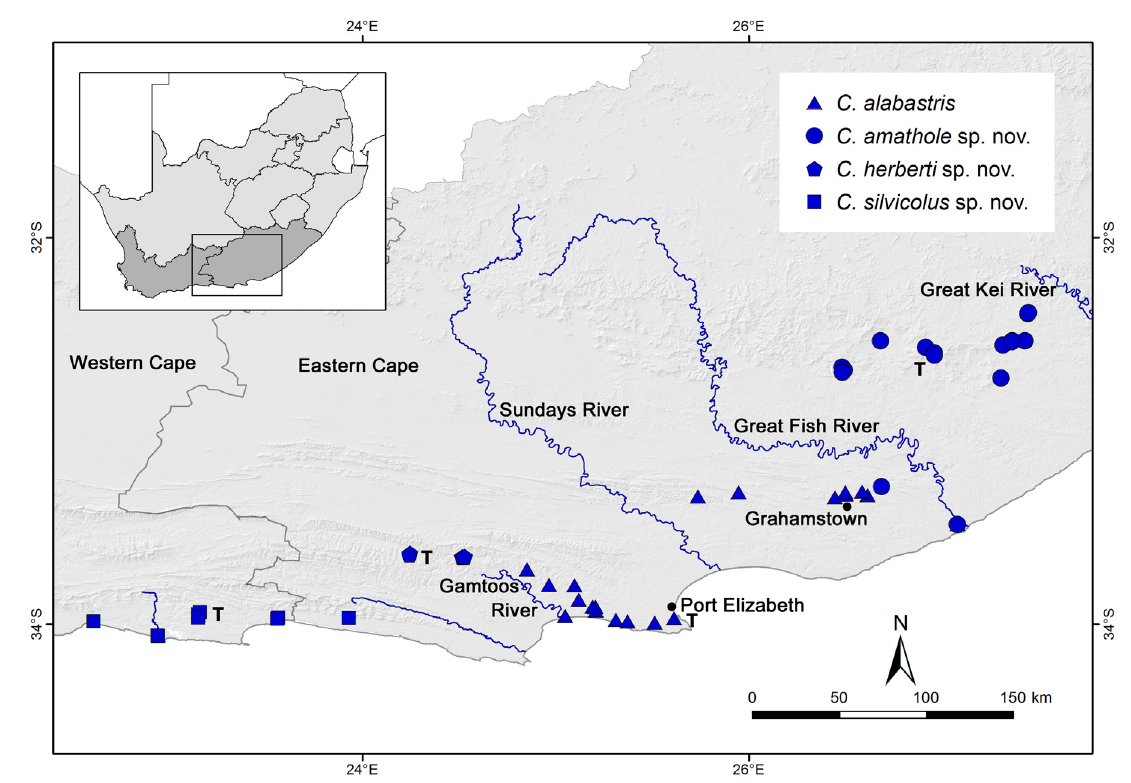
Fig. 9. Distribution map of Chondrocyclus species in the Southern-Eastern Cape clade in the southern Cape area of the Western Cape province and the western half of the Eastern Cape province. T indicates type localities. Major cities and rivers